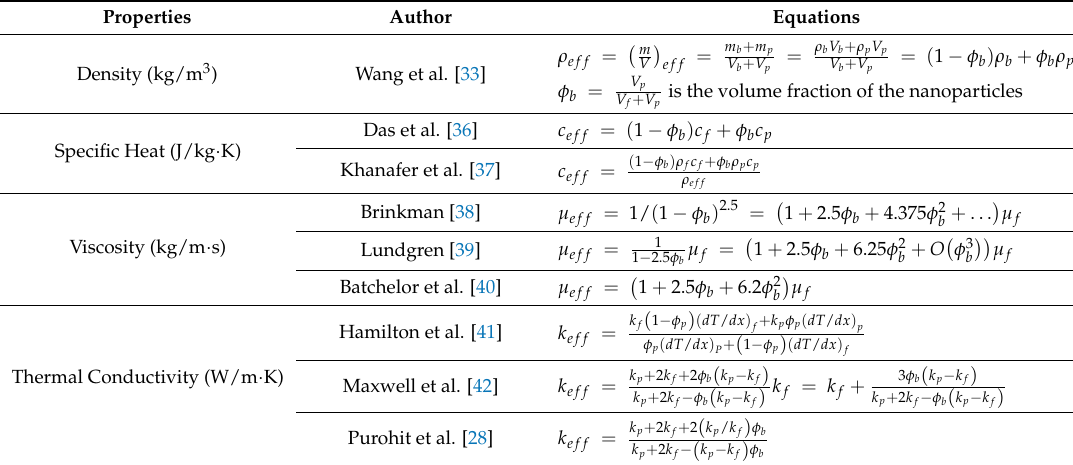
Table 2. Thermophysical properties equations of